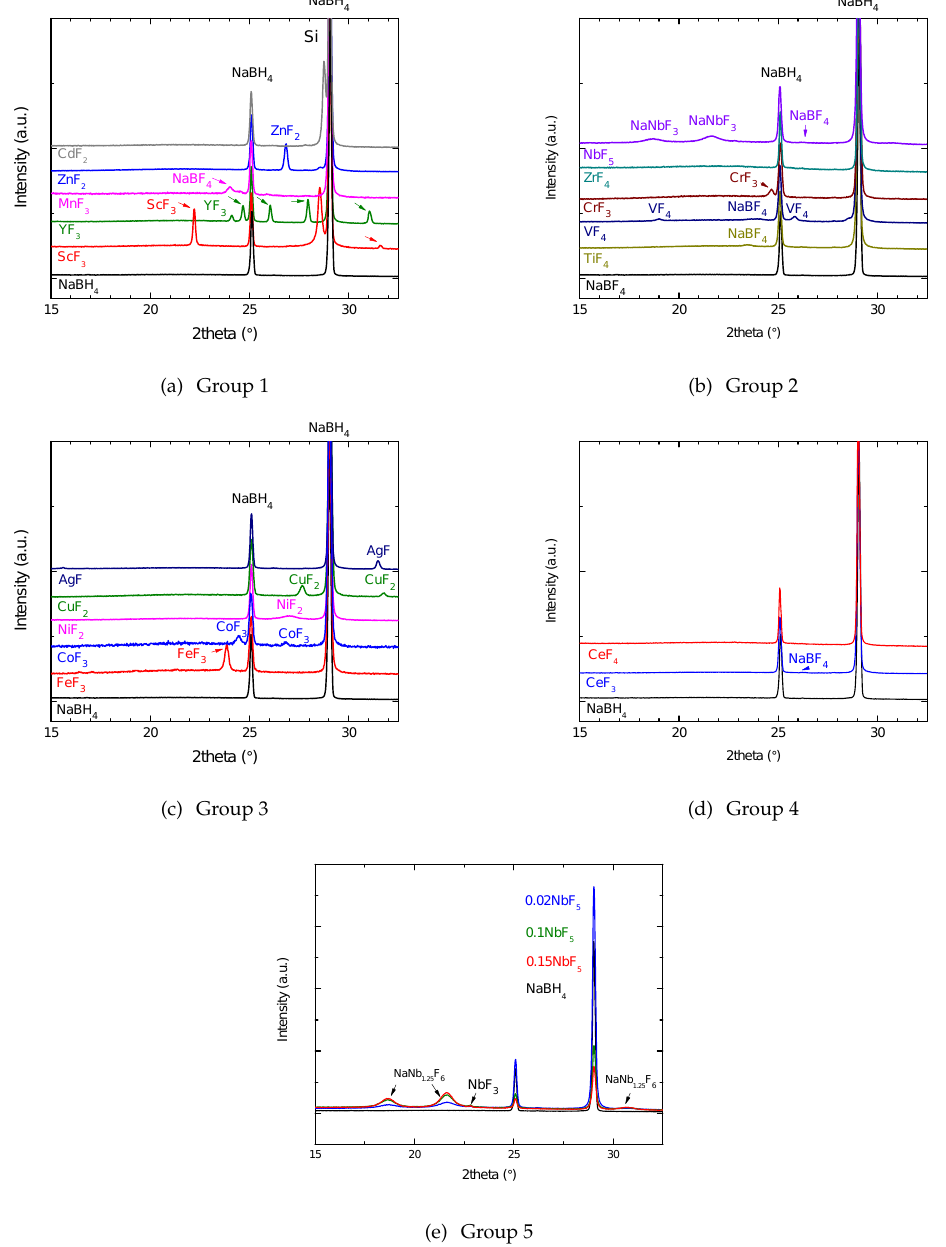
Figure A1. PXD data corresponding to the samples distributed in the different groups discussed in the